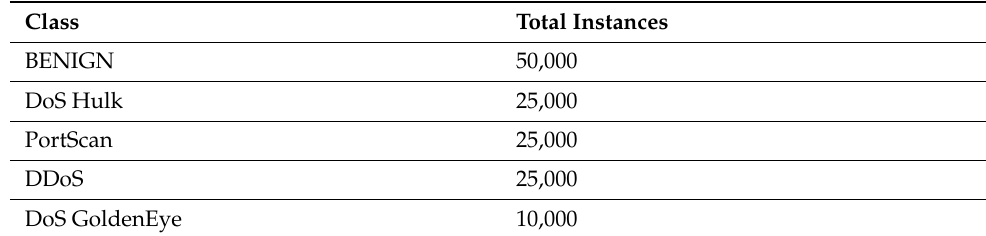
Table 4. Class wise Instances after Preprocessing.